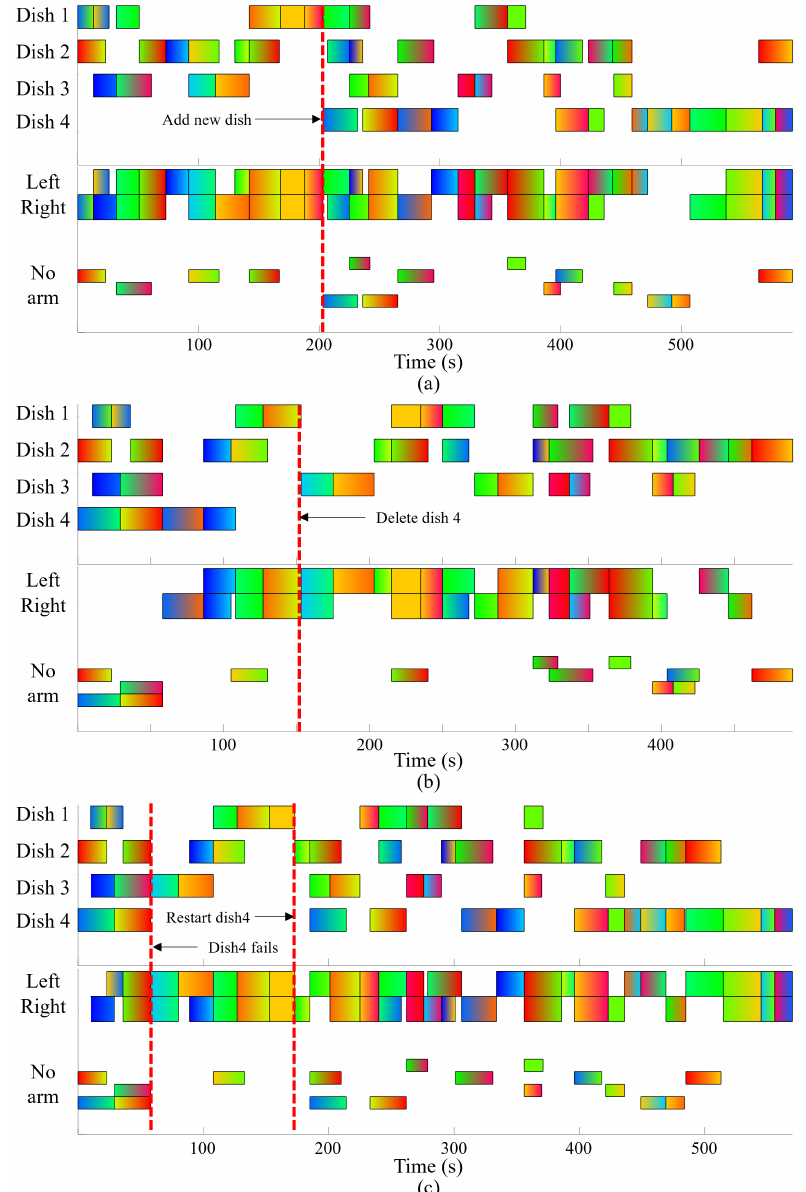
Figure 5. Examples of online planning. The red dashed line indicates the time at which the command was given. The result shows the change of planning result when the situation changes in the middle of planning. In all cases, planning was conducted well without any violation of the constraints. ( a ) The case of dish 4 being added in the middle of execution. ( b ) The case of dish 4 being removed in the middle of execution. ( c ) The case of dish 4 restarting after